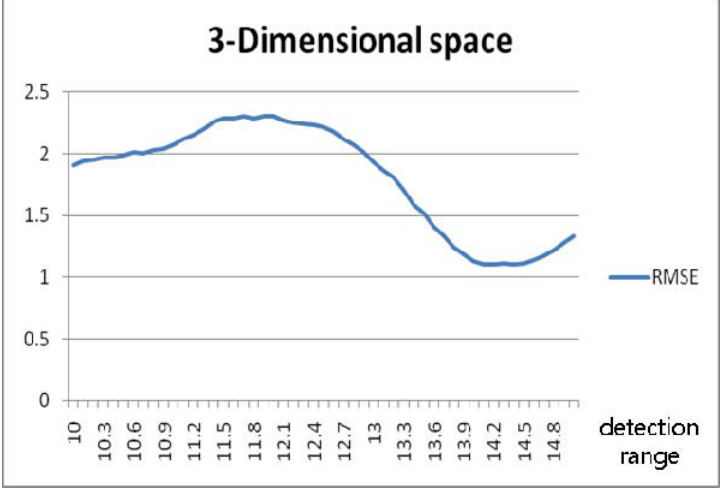
Figure 20. RMSE according to detection range in 3-dimensional